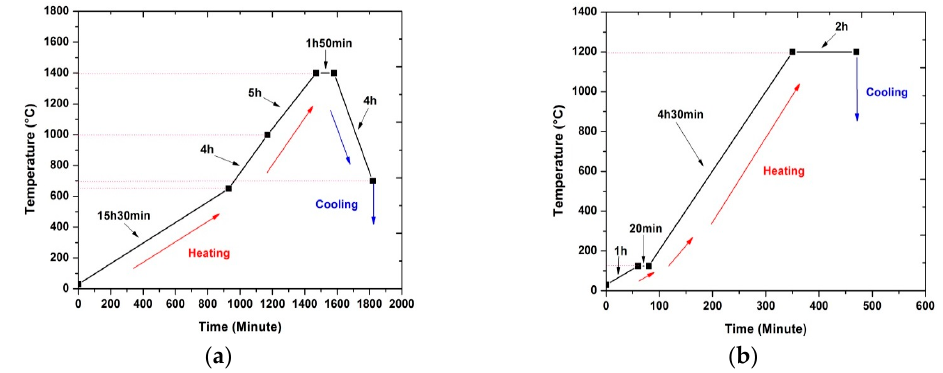
Figure 2. Diagram of the firing profiles for heat treatment of ( a ) the anode ‐ supported electrolyte and ( b ) the printed cathode layer.